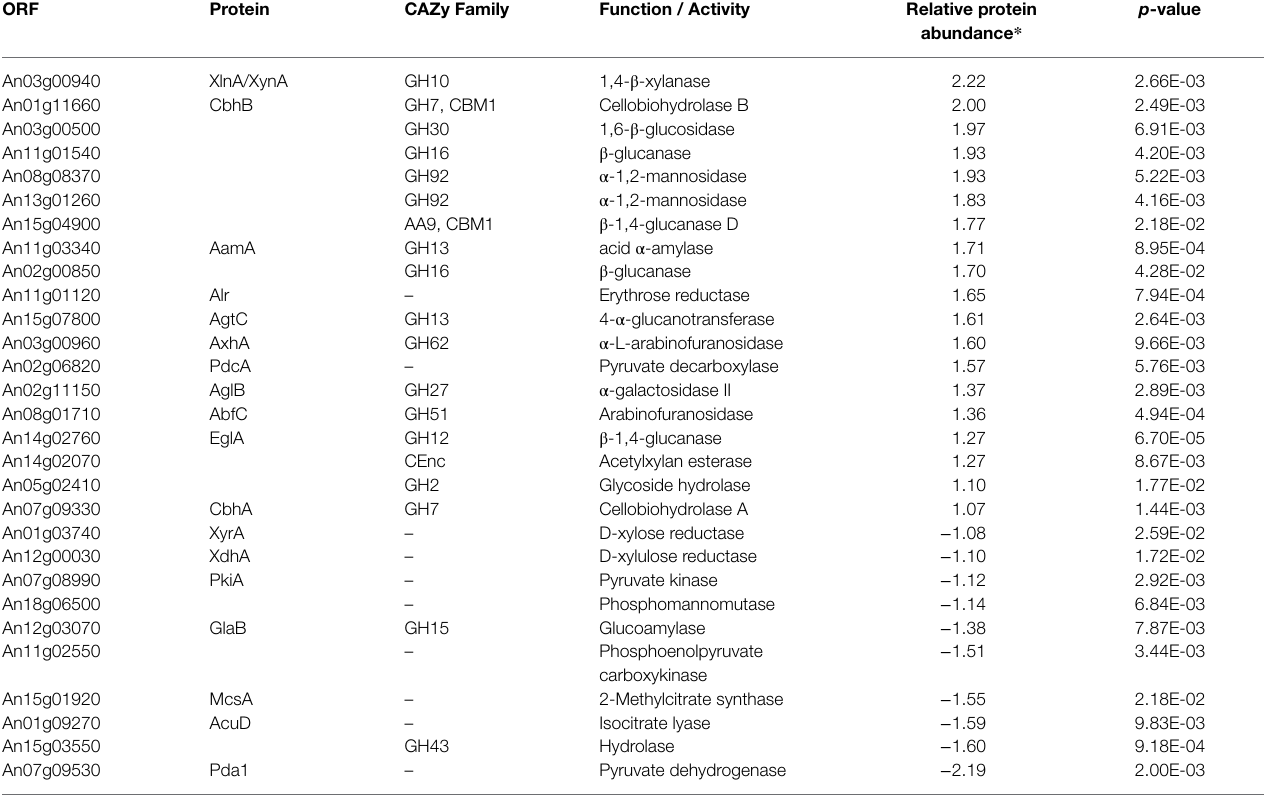
TABLE 3 | Differentially expressed proteins involved in carbohydrate metabolism. ORF Protein CAZy Family Function / Activity Relative protein